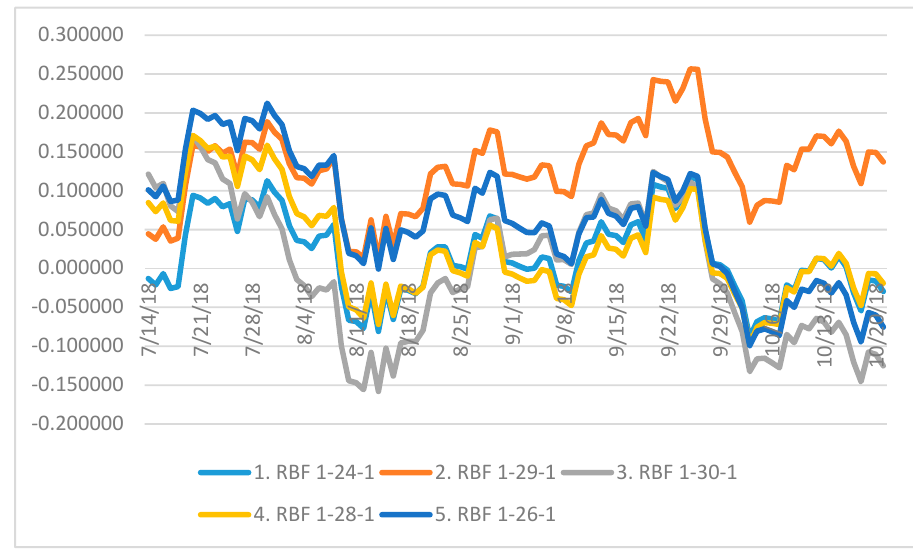
Figure 6. Development of equalized time series residuals between 14th July and 21st October 2018. (Source: Own processing.)